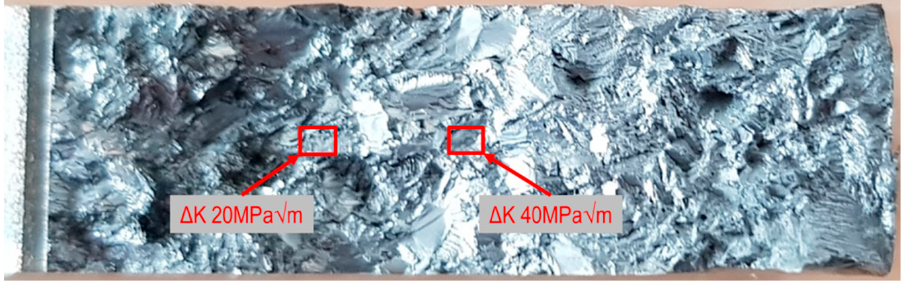
Figure 10. Positions of Figure 11; Figure 12 observation position.